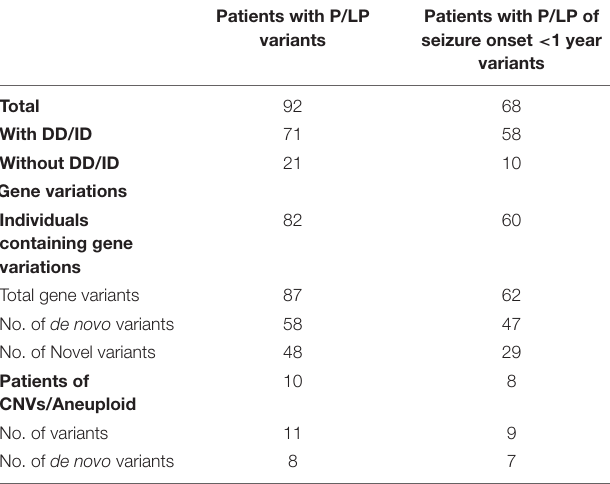
TABLE 1 | Number of patients with P/LP gene variants.